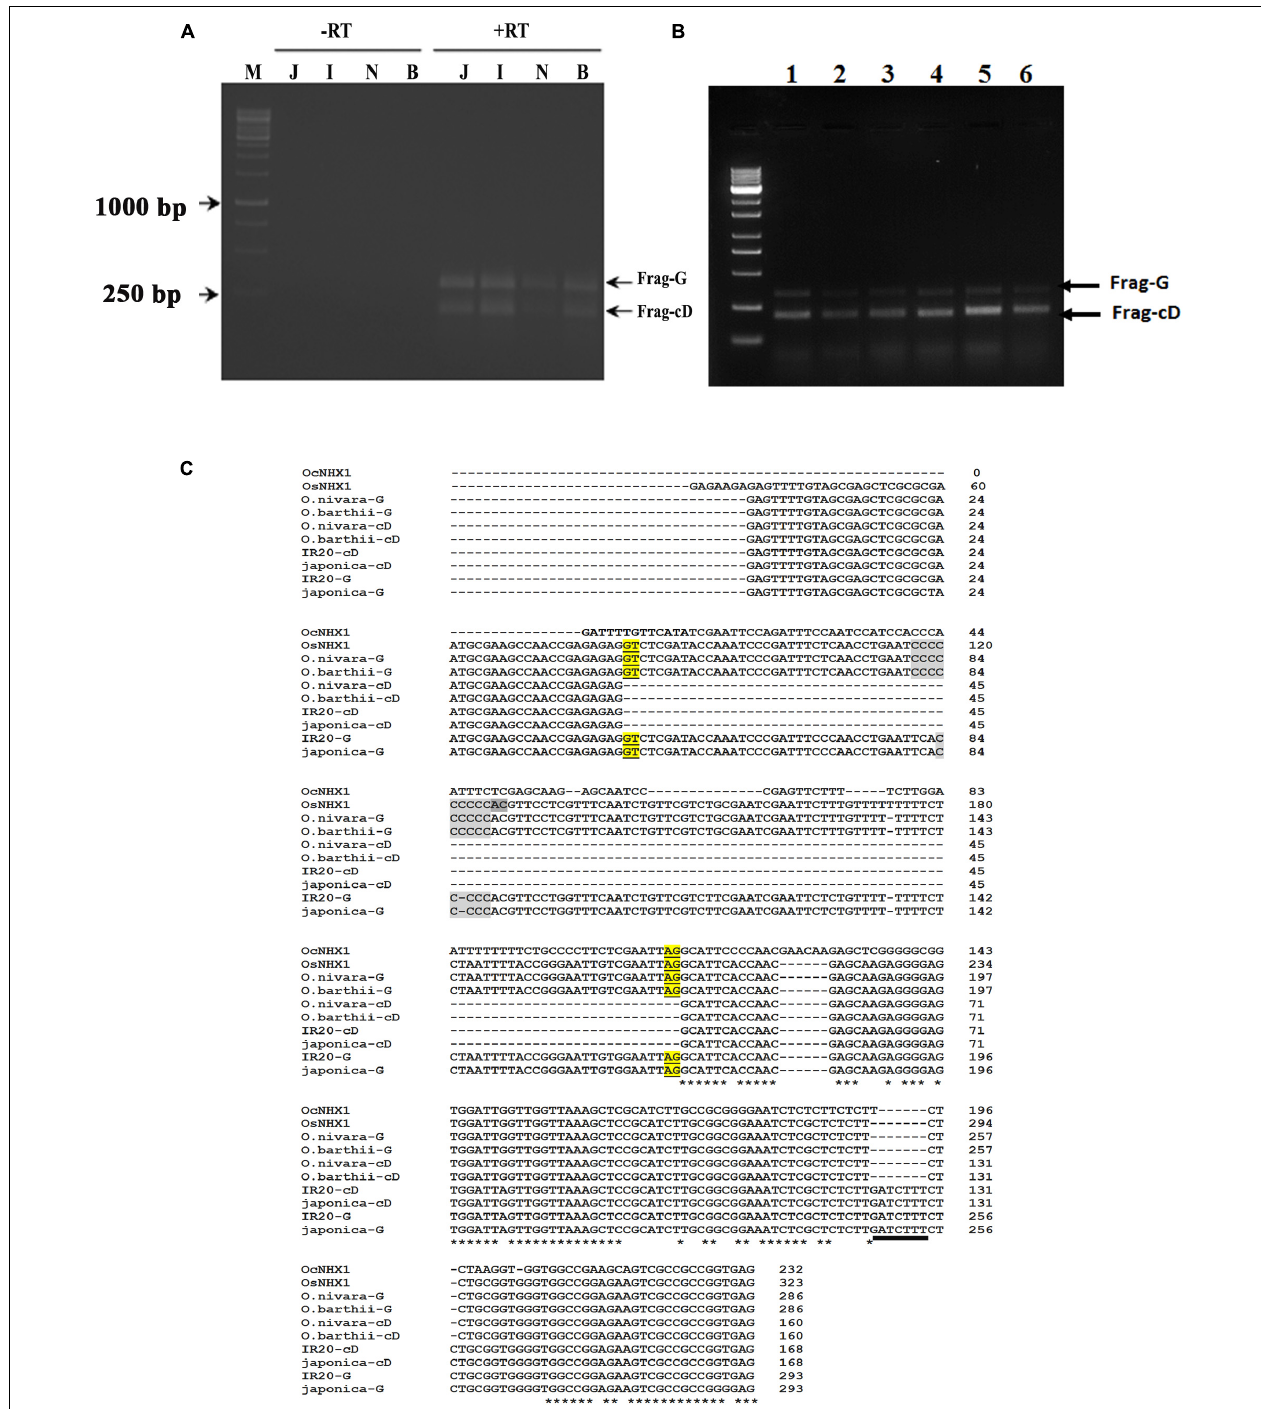
FIGURE 3 | Cloning of 5 (cid:48) UTR NHX1 splice variants from Oryza AA genome types. (A) RT-PCR analysis of NHX1 5 (cid:48) UTR splice variants from O. sativa [ssp. japonica (J), cv. IR20 (I), O. nivara (N), and O. barthii (B) that either retain the first intron (Frag-G) or splice it out (Frag-cD). M- Marker, Letter on top of each image indicate the rice spices; J- Japonica, I- indica IR20, N- O. nivara , and B- O. barthii ; -RT: PCR using DNase treated RNA, + RT: PCR using cDNA. (B) RT-PCR analysis of NHX1 5 (cid:48) UTR splice variants from O. barthii (1), O. nivara (2), O. glaberrima (3), O. sativa [ssp. japonica (4)] , O. sativa [ssp. indica cv. Pokkali (5)], O. rufipogon (6); (Frag-G), and (Frag-cD) are indicated. (C) RT-PCR fragments shown in (A) were cloned and sequenced. The O. sativa NHX1 cDNA fragments (cv. japonica and IR20 ) group together and show two distinct differences from O. nivara and O. barthii cDNA fragments: (i) length of a “C” repeat region in the intron and (ii) the presence of a “GATCTTT” insertion in the second exon that is underlined (5 (cid:48) UTR); the “GATCTTT” insertion also occurs in O. rufipogon and O. longistaminata ( Supplementary Figure S6 ).